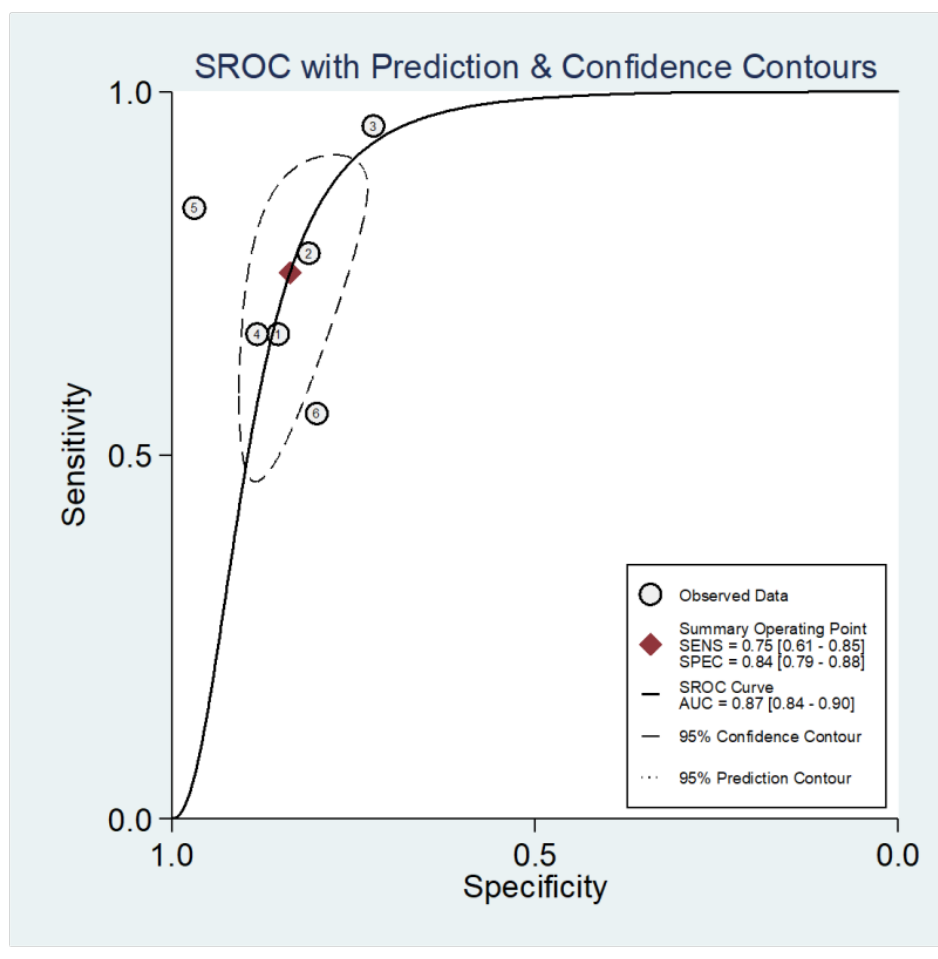
Figure 3. sROC curve with prediction and confidence contours of the six prediction models with renal function deterioration as predicted outcomes.